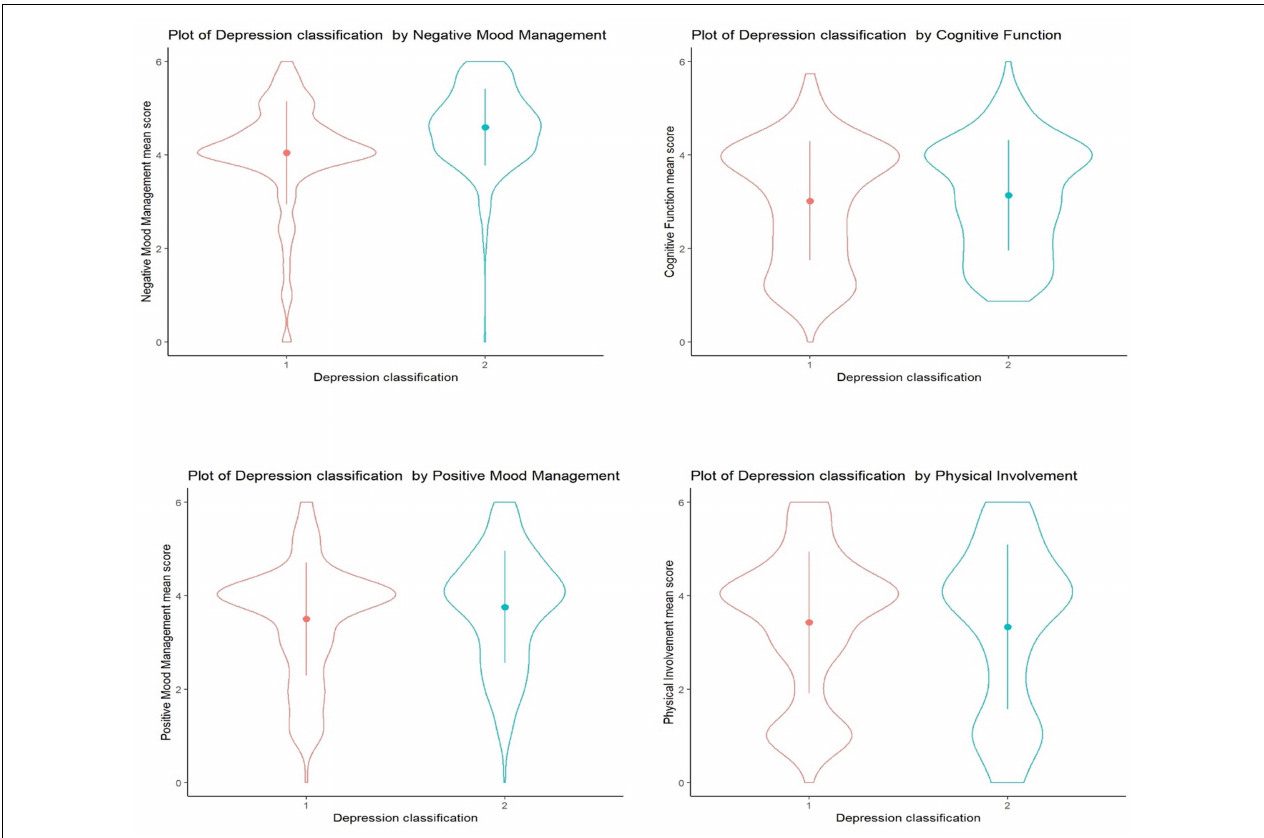
FIGURE 2 | Violin plots representing the distribution of the data for each factor by groups. 1, no depression; 2, severe depression.